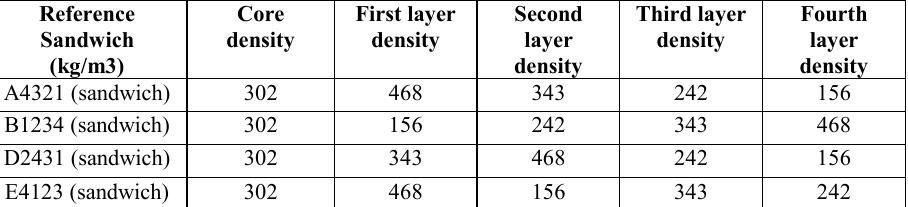
Table 1. Setting Basic characteristics of the graded core sandwich